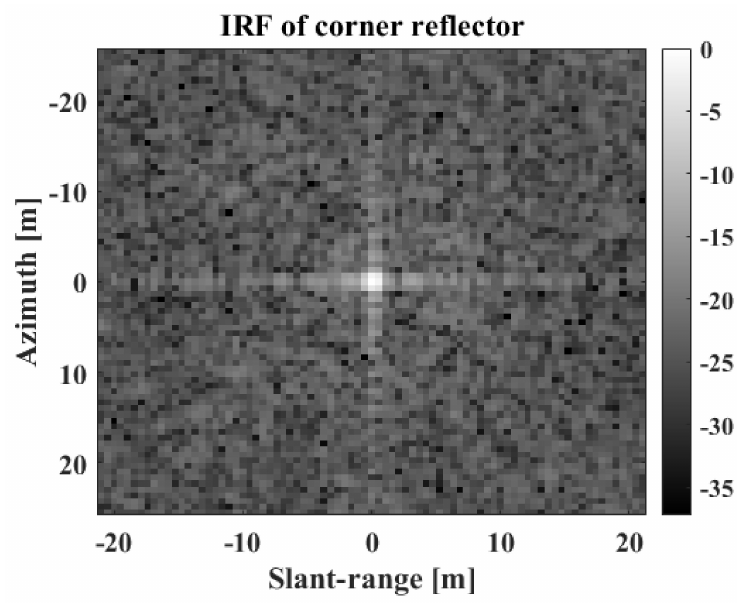
Figure 5. IRF of corner